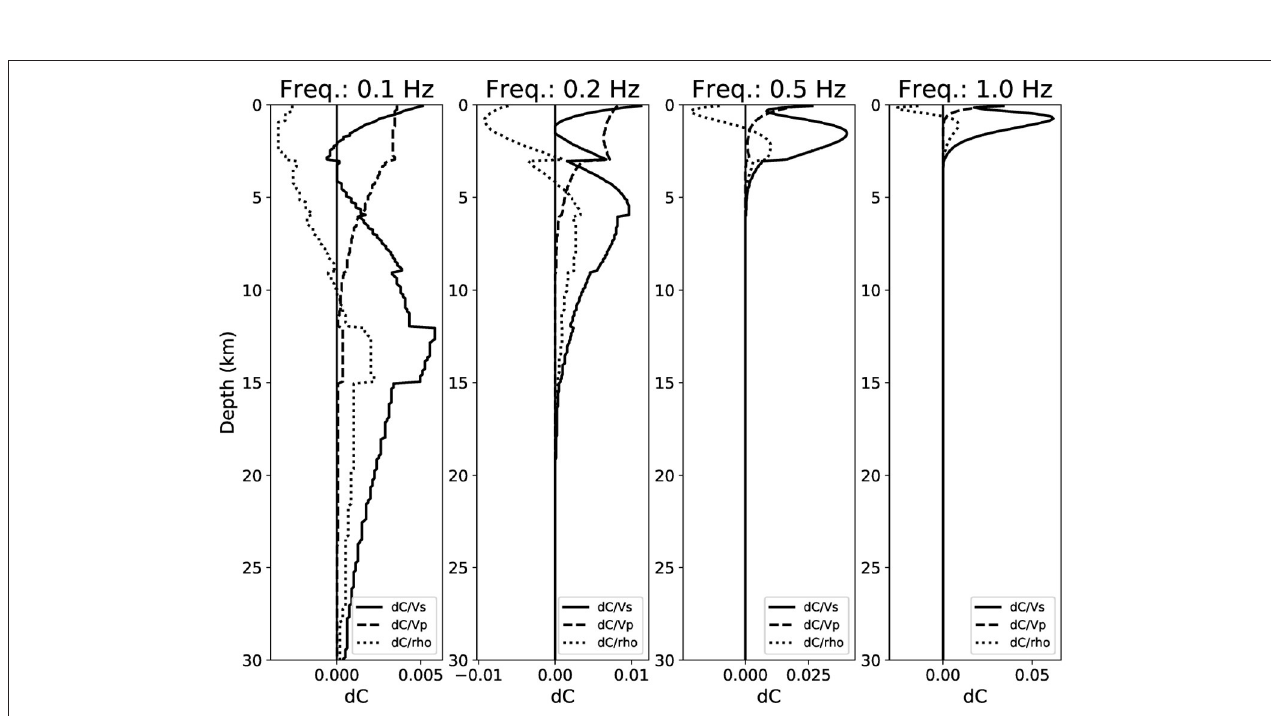
FIGURE 8 | Sensitivity kernels for the phase velocity as a function of v S , v P , and density computed using a modal summation approach (Herrmann, 2013) using the 1D model of the Val d’Agri area by Valoroso et al. (2009).